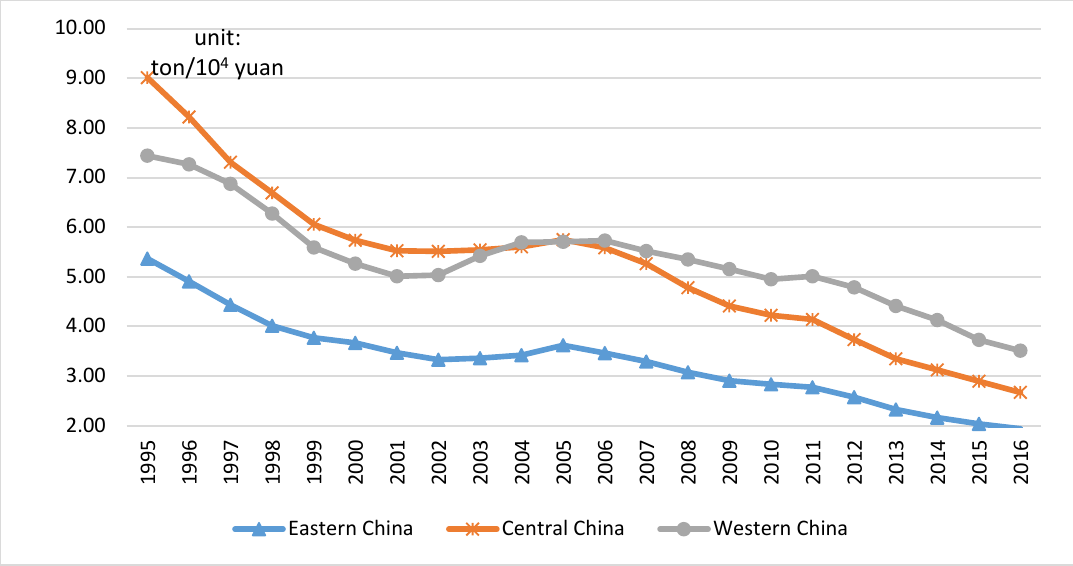
Figure 4. 1995–2016 energy intensity of eastern, central, and western China.